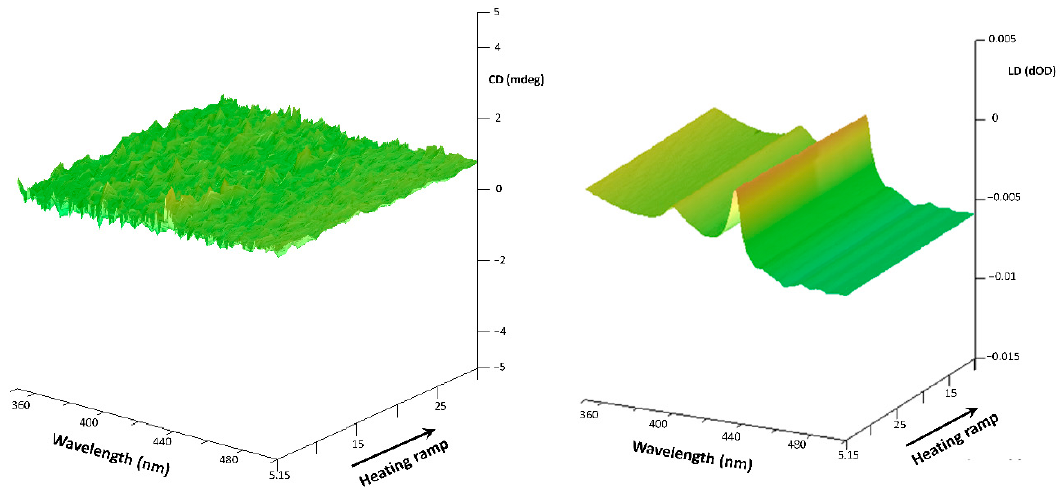
Figure 12. 3D CD spectra of the water solution of StarP-F, acquired in heating thermal ramp ( left ) and the relative 3D LD spectra ( right ), in the temperature interval 5–30 °C, relatively to the aggregates having size <0.45 µm.